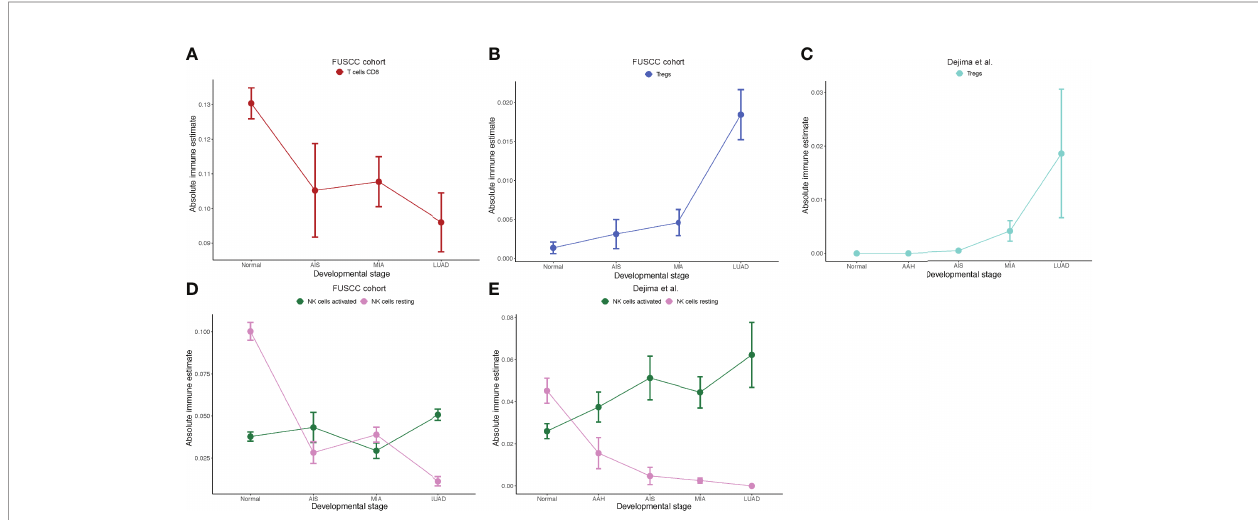
FIGURE 3 | Immune cell in fi ltration inferred by CIBERSORT. (A) Prediction of number of CD8+ T cells in the Fudan University Shanghai Cancer Center (FUSCC) cohort. (B) Prediction of number of Tregs in the FUSCC cohort. (C) Prediction of number of Tregs in Dejima ’ s cohort. (D) Prediction of number of activated and resting natural killer (NK) cells in the FUSCC cohort. (E) Prediction of number of activated and resting NK cells in Dejima ’ s